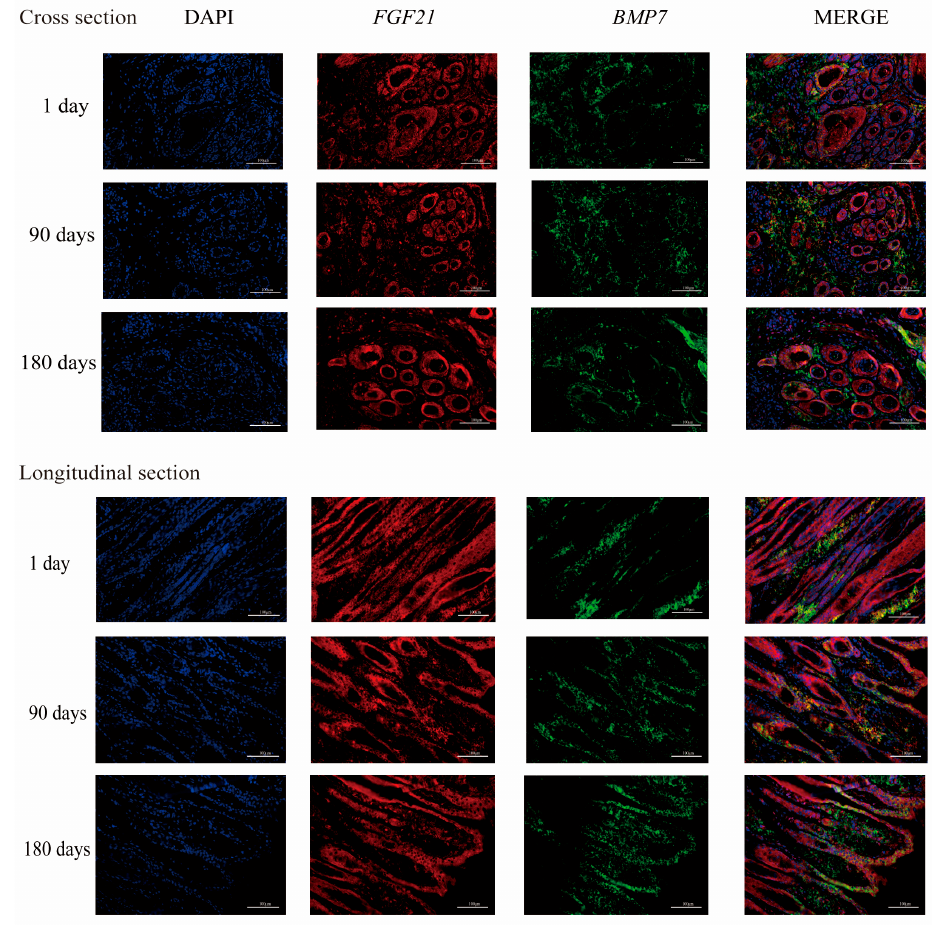
Figure 3. Immunofluorescence for FGF21 and BMP 7 in skin and hair follicle sections. Fluorescence signal DAPI (blue), FGF21 (red), BMP 7 (green), Scale bar = 100 μ m.